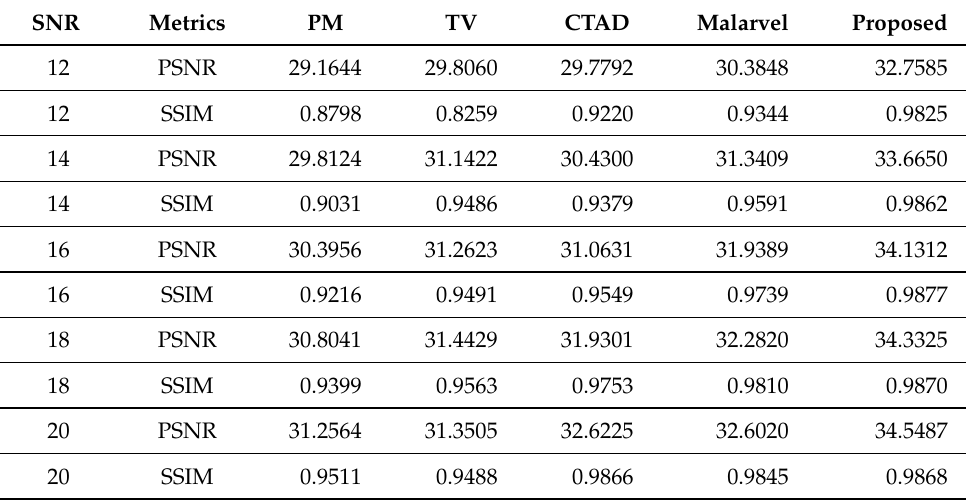
Table 1. Results evaluation on artificial image 1.